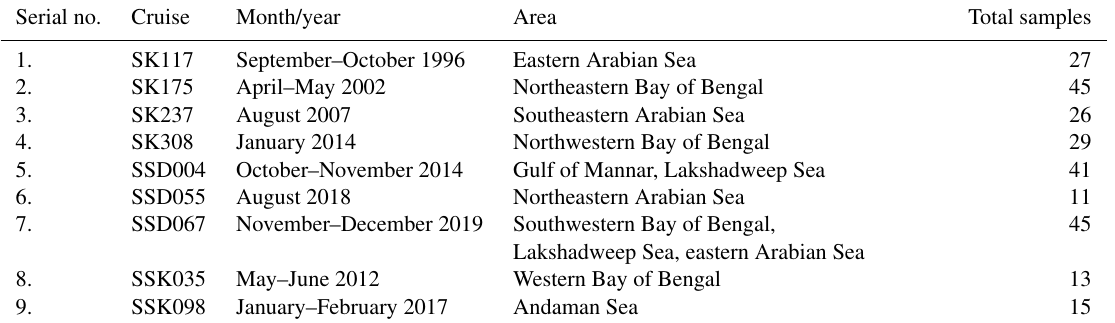
Table 1. Details of the timing, region, and the number of surface sediment samples collected in each expedition used in this study (SK is Sagar Kanya , SSD is Sindhu Sadhana , and SSK is Sindhu Sankalp ). Serial no.